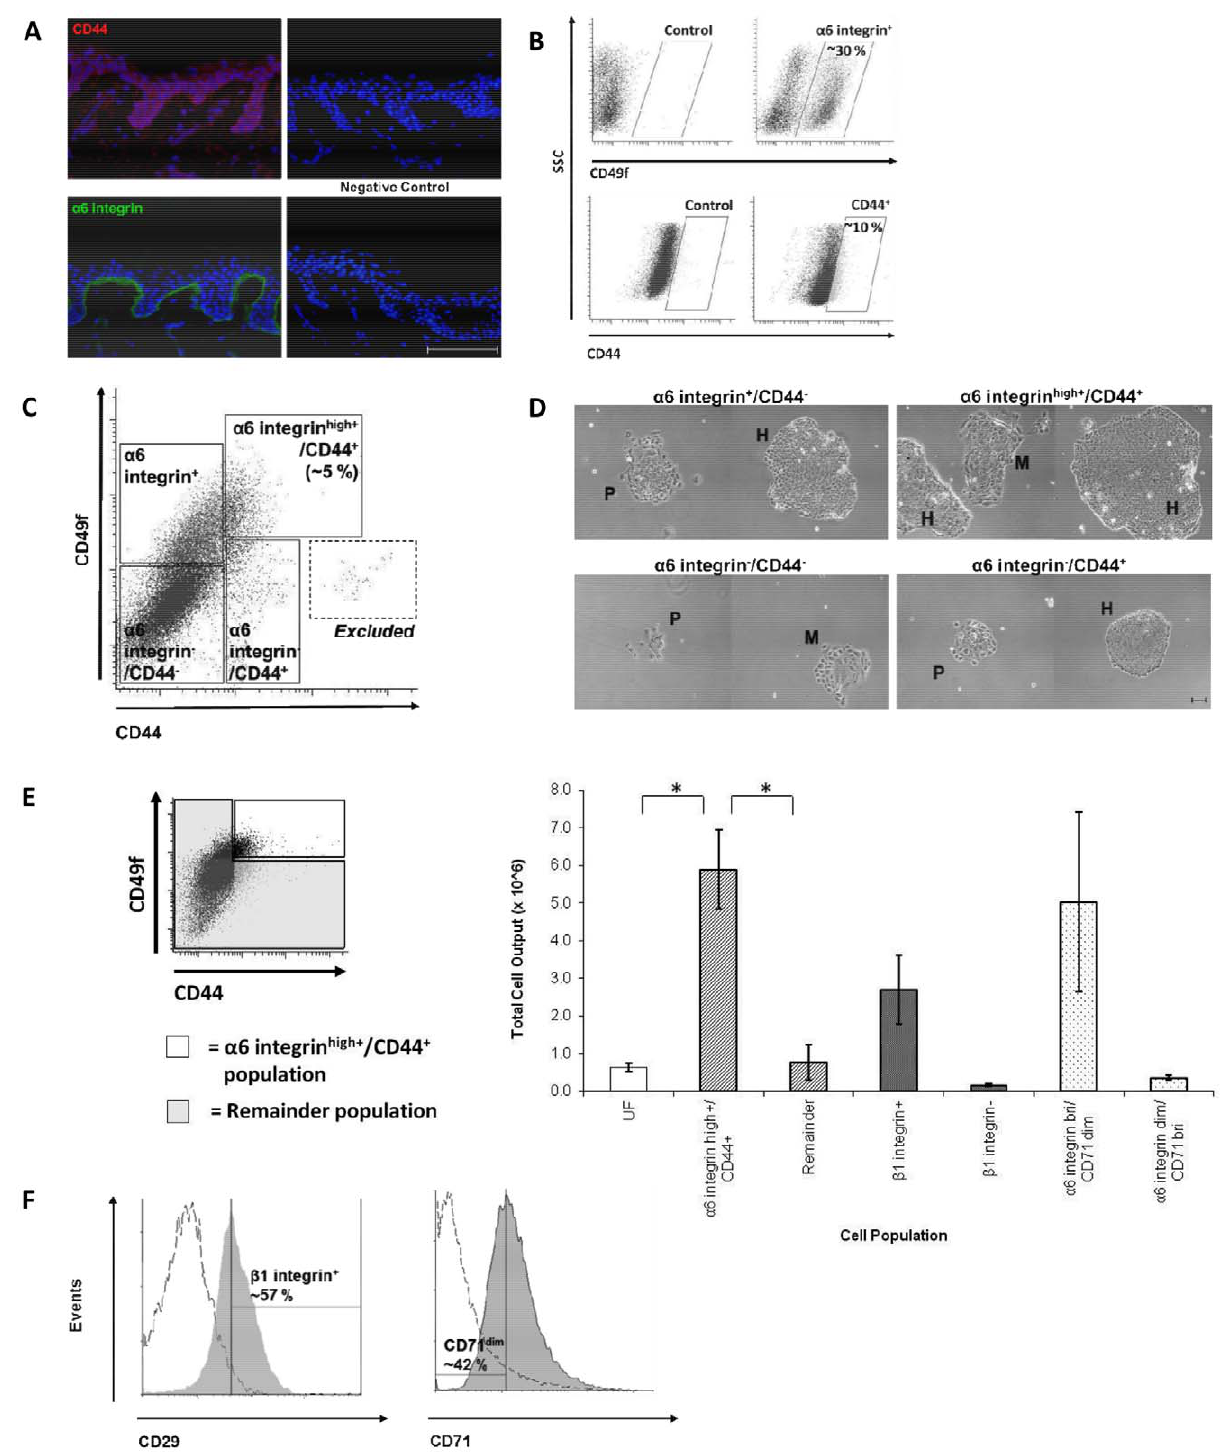
Figure 1. a 6 integrin and CD44 identify a subset of human keratinocytes with long-term growth properties. (A) Immunofluorescence histochemistry of frozen normal human skin probed with an antibody against CD44 (red) or a 6 integrin (green). Negative controls probed with blue nuclear stain (DAPI) only. Representative images of n=3; scale bar=100 m m. (B) Primary keratinocytes analysed for expression of a 6 integrin using flow cytometry showed an average of , 30% a 6 integrin + cells and , 10% CD44 + cells (n=5). (C) Primary keratinocytes analysed for co-expression of both a 6 integrin and CD44 using FACS Diva software. The CD44 + population that also highly expressed a 6 integrin could be manually gated at about , 5% of the whole cell population (n=25). ‘Excluded’ cells are 3T3 mouse fibroblasts remaining from the feeder layer used in the culture process. (D) The four populations identified in (C) were separated using FACS and grown in vitro for 7 days to analyse colony morphology; H=holoclone-like, M=meroclone-like and P=paraclone-like. (E) Cultured keratinocytes were separated into two populations based upon high a 6 integrin and CD44 expression ( a 6 integrin high + /CD44 + ) and the remainder of the cell population (a total of the a 6 integrin + , CD44 + , and a 6 integrin 2 / CD44 2 fractions).